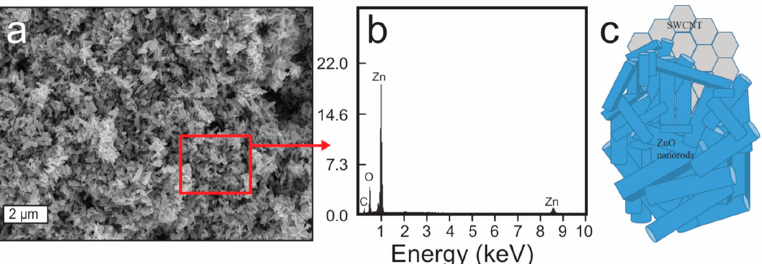
Figure 2. ( a ) FE-SEM micrograph of the ZnO–SWCNT nanocomposite. ( b ) An EDX spectrum corresponding to the region in the rectangle in Figure 2a. ( c ) Schematic of the hybrid nanocomposite structure in which an SWCNT is covered with ZnO nanorods.